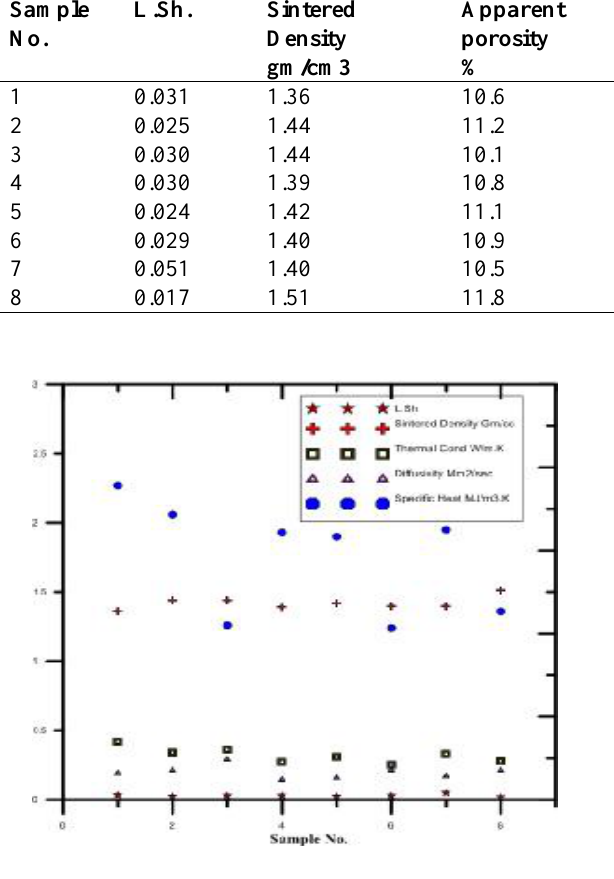
thermal conductivity, and the diffusivity for the Porcelanite prepared refractory as a function of Al O 2 3